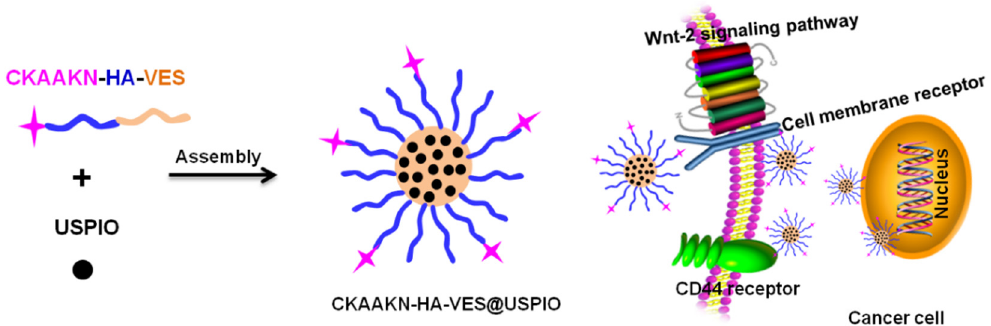
Figure 15. Modification of CKAAKN-HA-VES onto USPIO and illustration of BxPC-3 cancer cell tracking. Adapted from reference [44].